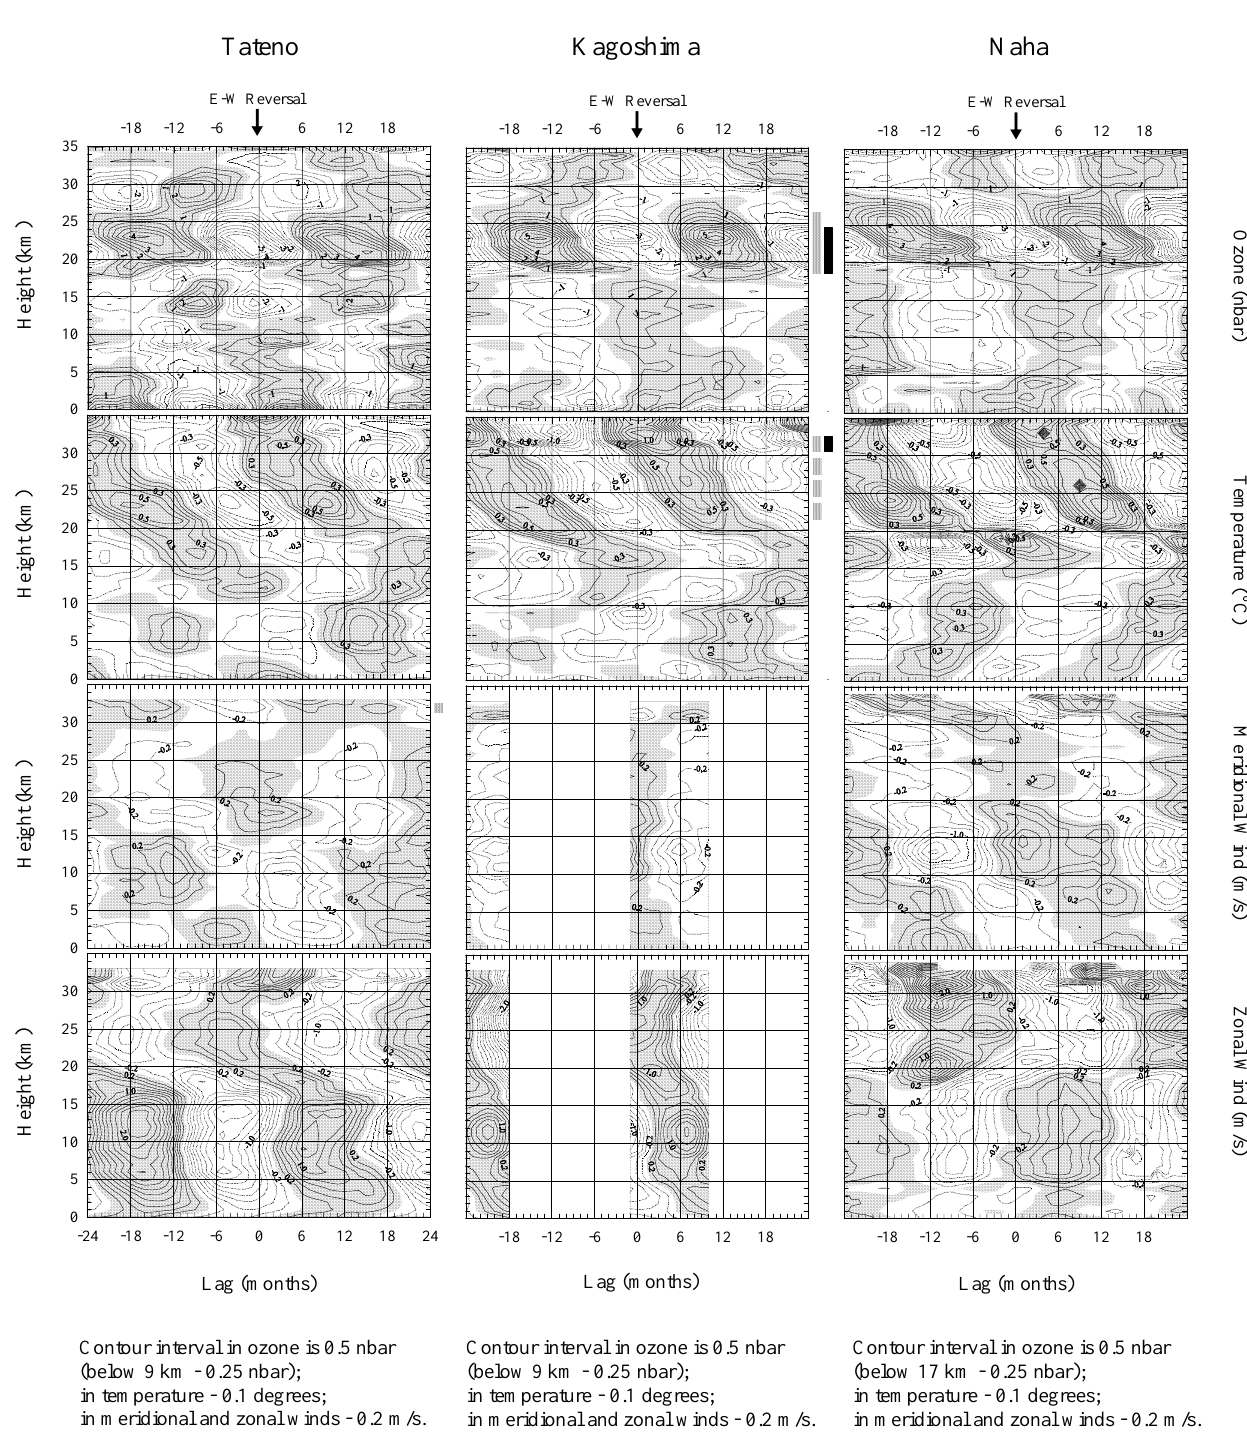
Contour interval in ozone is 0.5 nbar (below 17 km - 0.25 nbar); in temperature - 0.1 degrees; in meridional and zonal winds - 0.2 m/s.